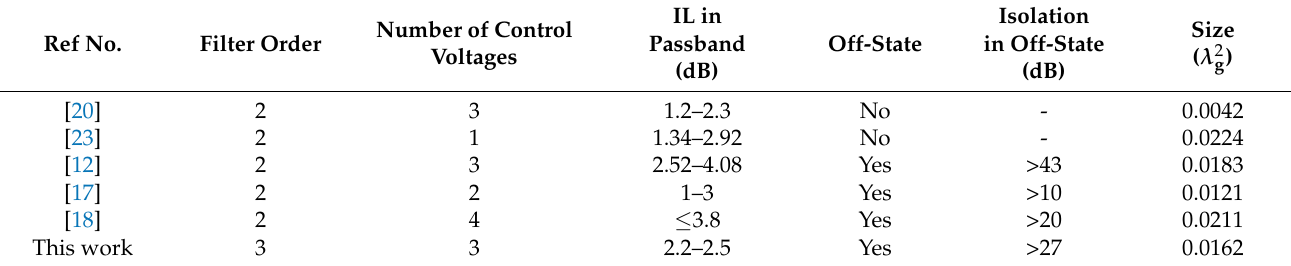
Figure 13. Simulated and measured S parameters for the proposed filter in off-state. Table 2. Comparisons with previously reported tunable CABW filters.